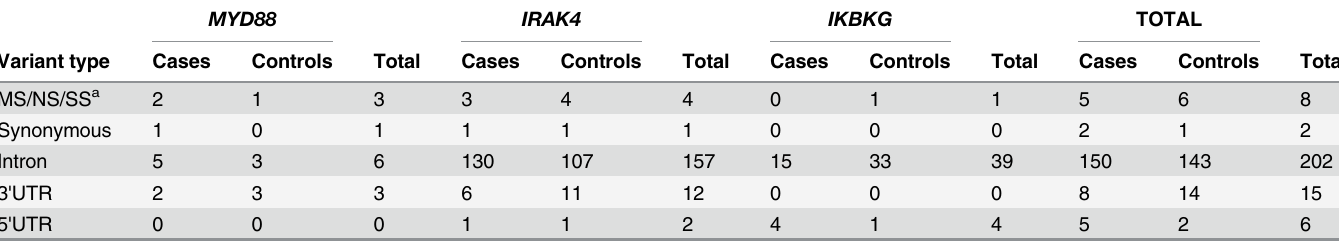
Table 1. Single nucleotide variant types identified in MYD88 , IRAK4 and IKBKG . MYD88 IRAK4 IKBKG